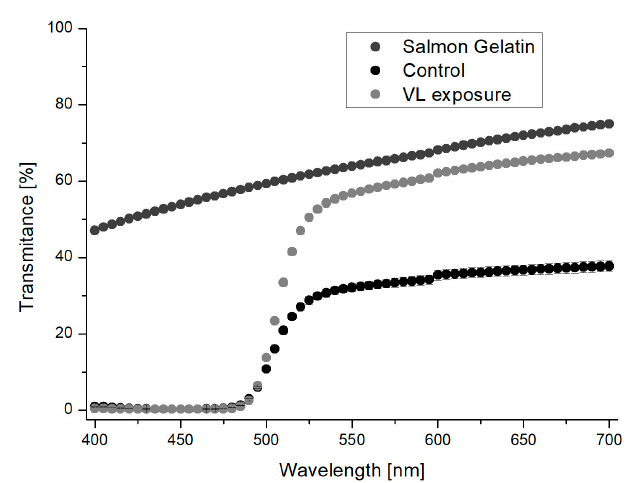
Figure 5. Transmittance (%) visible spectrum (400–700 nm) of a salmon gelatin solution (SG), control samples (SG–Rf pH 8.5) and crosslinked samples (SG–Rf pH 8.5 with VL).